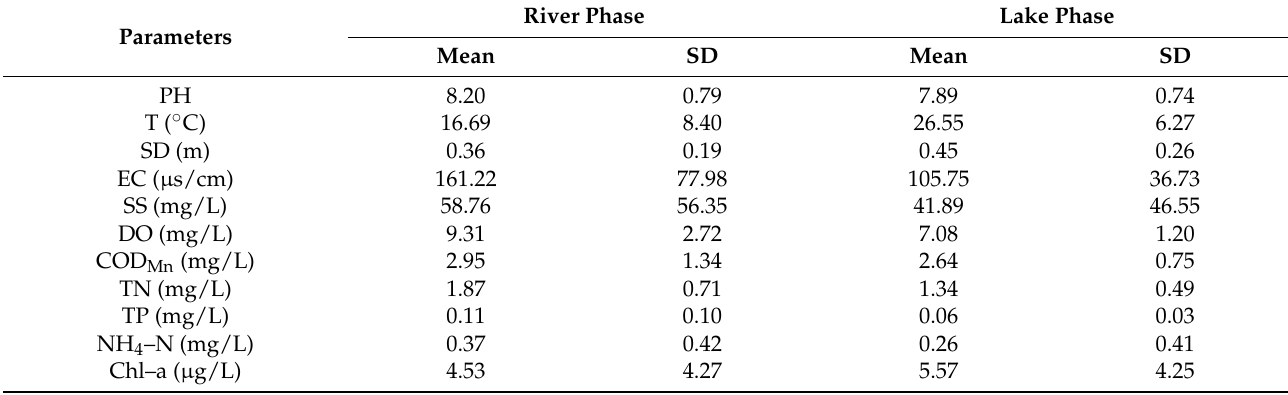
Table 2. Comparison of water quality parameters between the river and lake phase of Poyang Lake from 2009 to